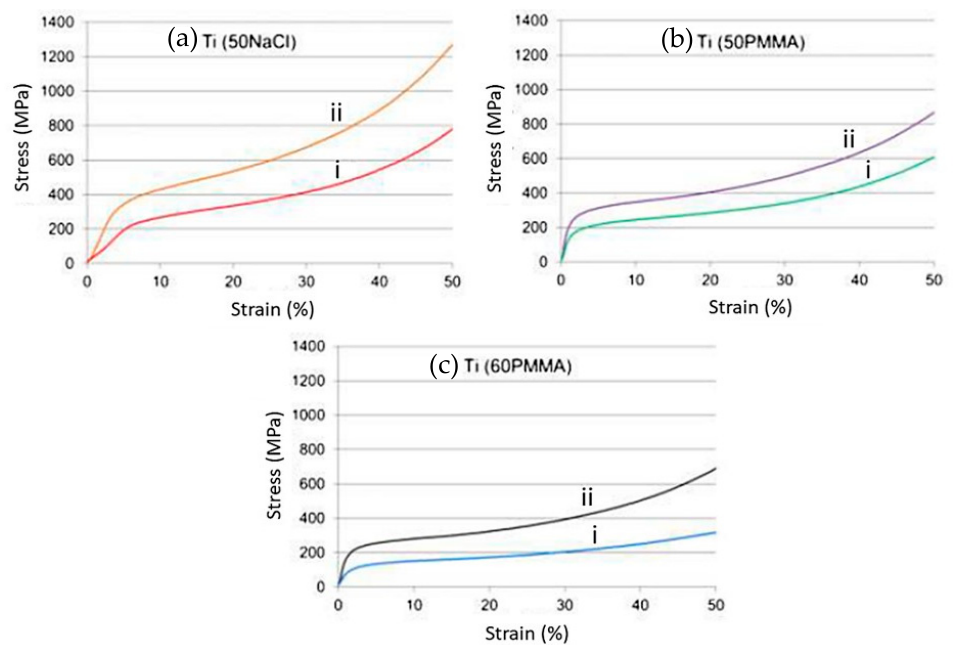
Figure 8. Compression behavior of porous titanium parts sintered at 1000 °C (i) and 1200 °C (ii) with ( a ) 50% of NaCl, ( b ) 50% of PMMA, and ( c ) 60% of PMMA as SH. Adapted with permission from Ref. [22]. Copyright 2022, Taylor and Francis.